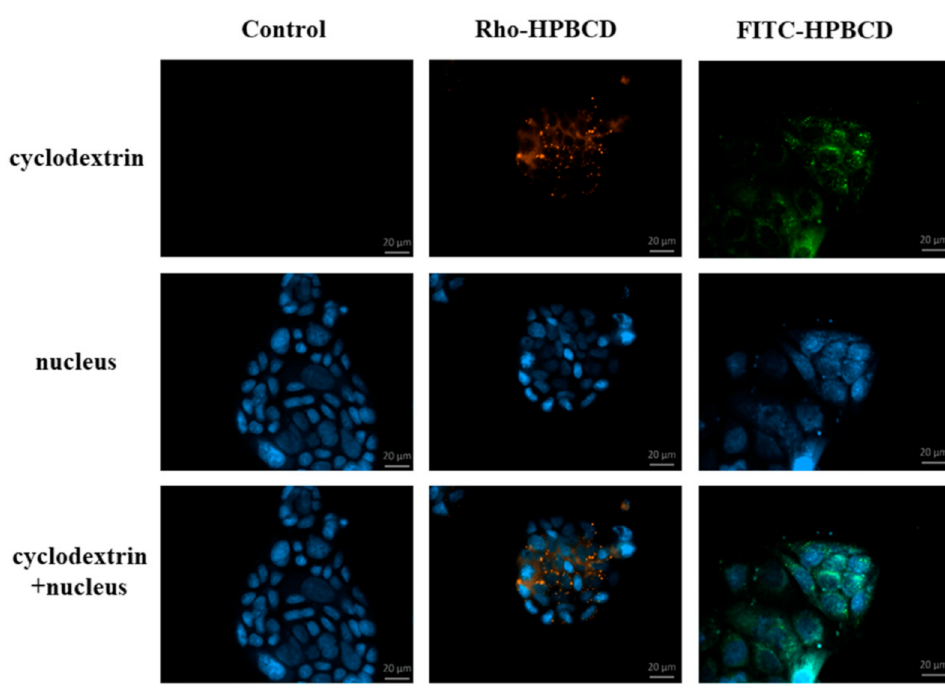
Figure 3. Fluorescence microscopic images of FITC-HPBCD, Rho-HPBCD and untreated Caco-2 intestinal epithelial cells. Both derivatives entered the cells and localized in small vesicles along the cell membrane and in larger granules around the nucleus. (Green-FITC-HPBCD, red-Rho-HPBCD, blue-cell